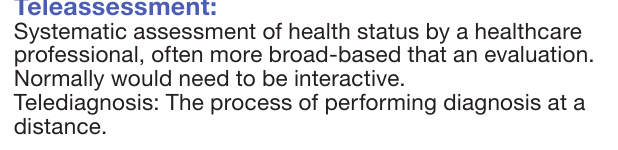
Table 2: Classification of clinical activities for remote service